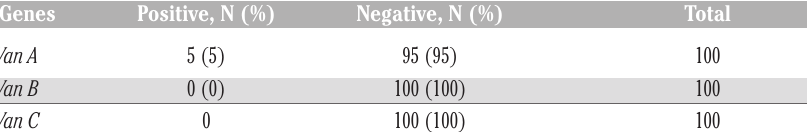
Table 5. The number of strains containing VanA, VanB, VanC